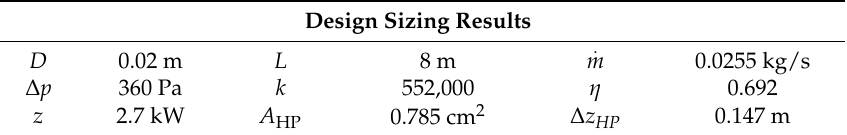
Table 2. Results of design